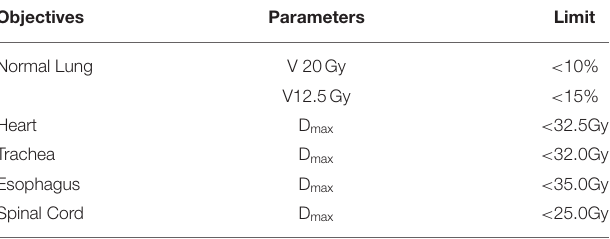
TABLE 1 | Planning objectives for critical structures.